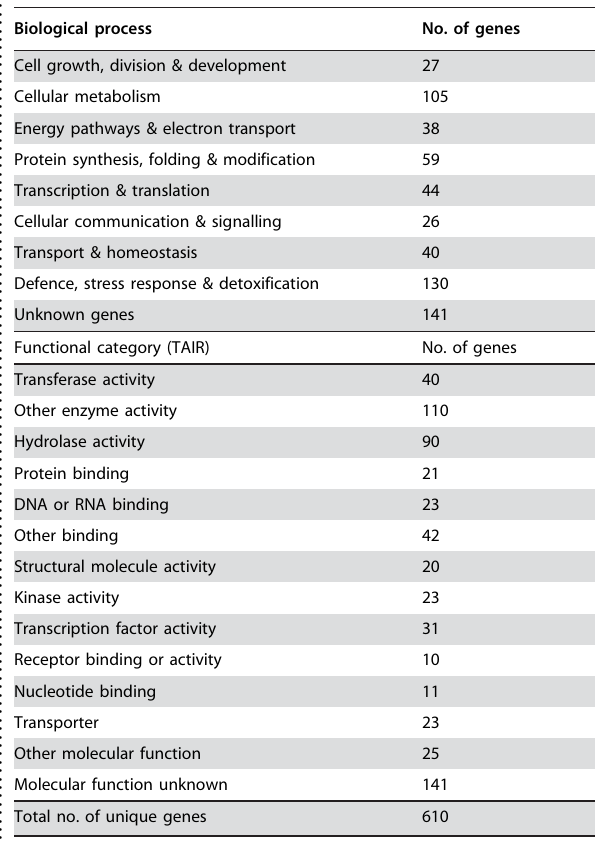
Table 1. GO Annotation of B. divaricarpa Genes Identified